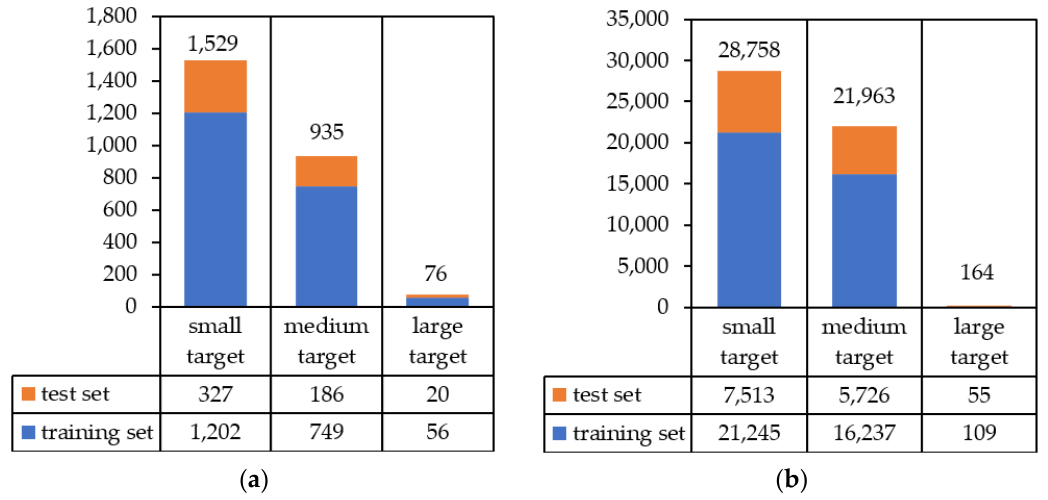
Figure 6. Statistics of different size ships in the datasets. ( a ) Statistics of the SSDD ships; ( b ) statistics of the SARShip ships.